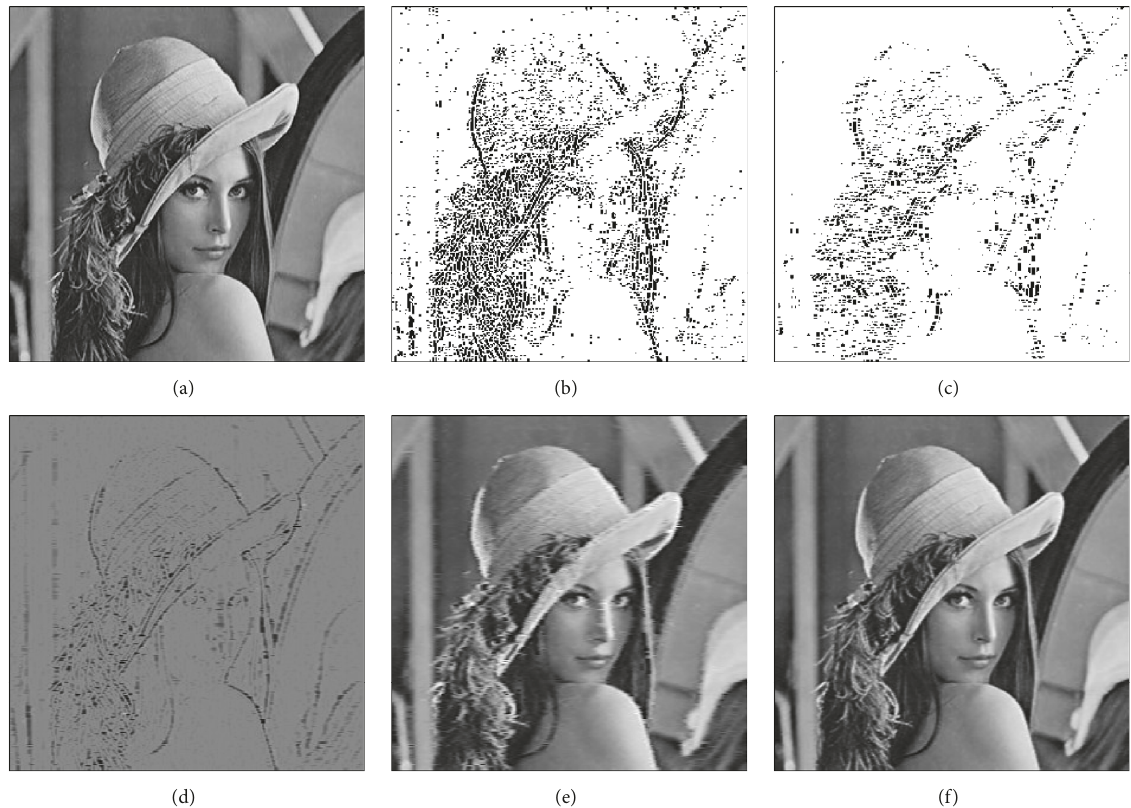
Figure 4: Decomposition (a), component extraction and representation of high frequency component ( 𝜆 ∈ [0, 0.1] ) (b), medium frequency component ( 𝜆 ∈ [0.5, 0.7] ) (c), high and medium frequency component ( 𝜆 < 1 ) (d), low frequency component ( 𝜆 = 1 ) (e), and recomposition of all components